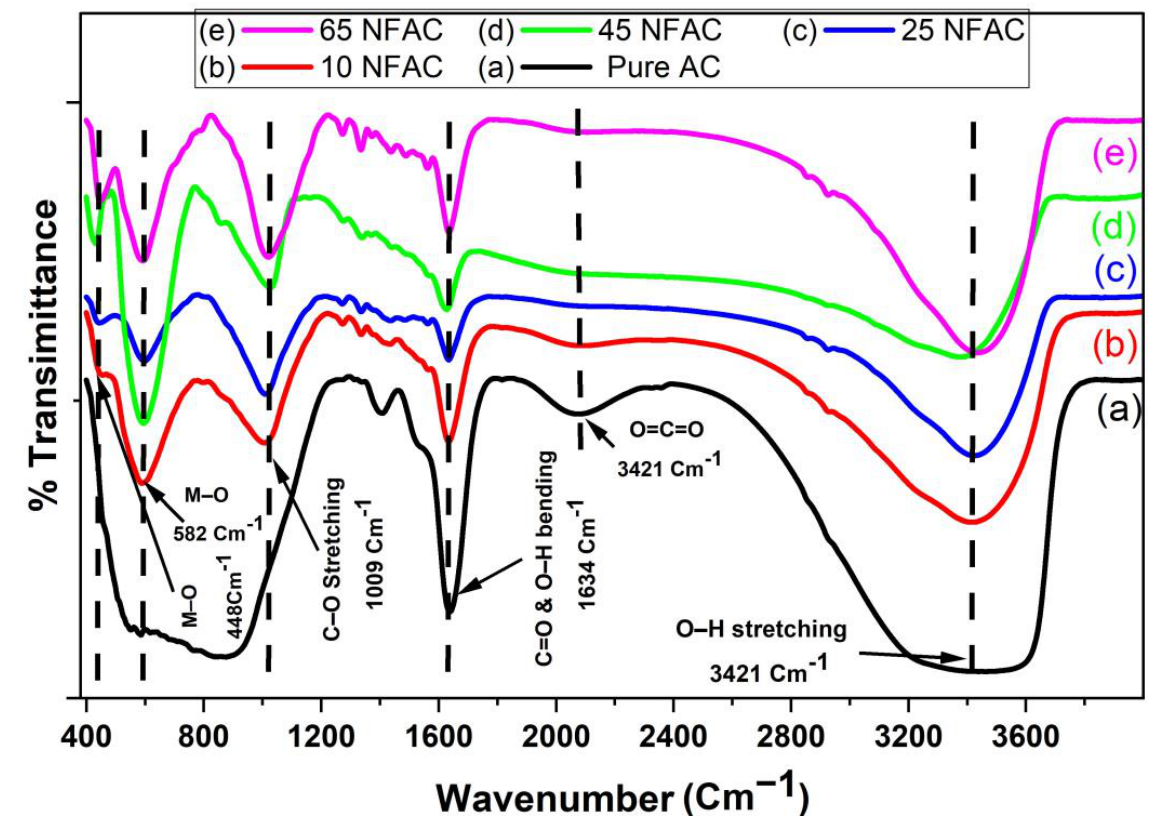
Figure 2. FTIR Spectra of ( a ) pure AC, ( b ) 10NFAC, ( c ) 25NFAC, ( d ) 45NFAC, and ( e ) 65 NFAC.